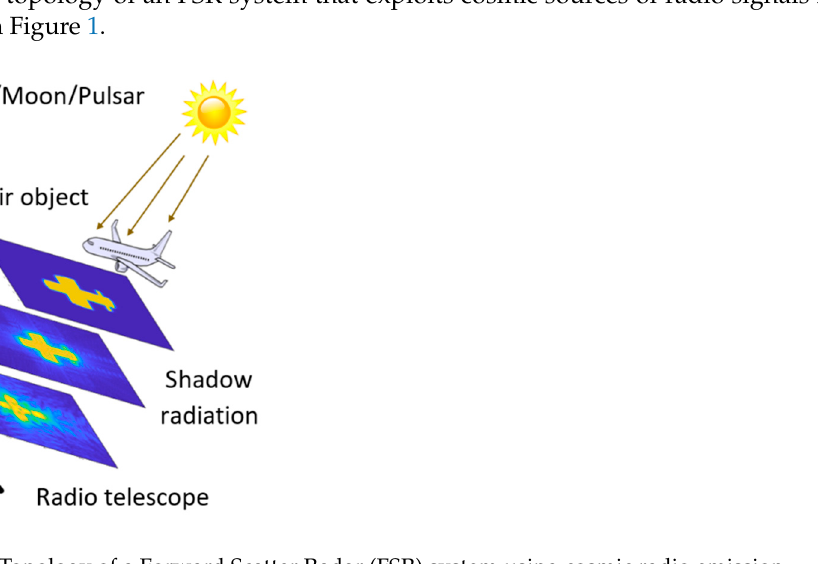
Figure 1. Topology of a Forward Scatter Radar (FSR) system using cosmic radio emission.